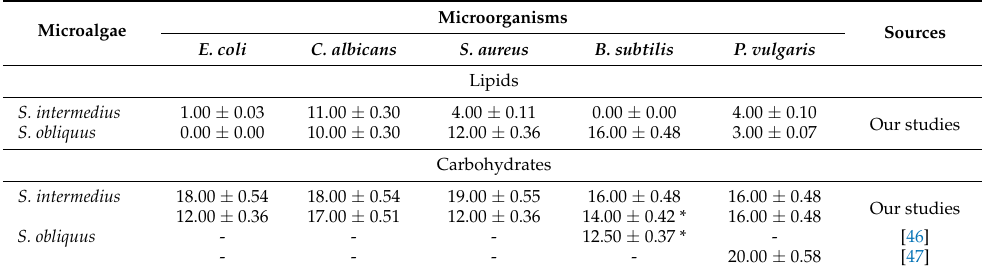
Table 7. Values of antimicrobial activity (diameter of the inhibition zone, mm) in S. typhimurium and S. obliquus microalgae samples obtained in various